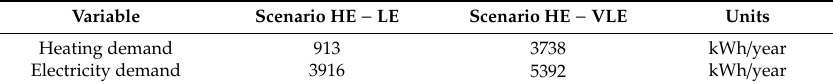
Table 5. Di ff erence in energy